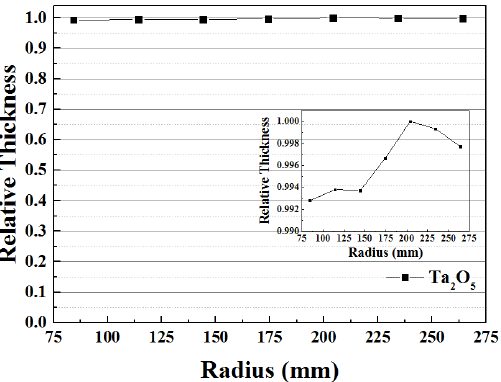
Figure 9. Relative thickness of Ta 2 O 5 thin film deposited on a large substrate with a radius of 275